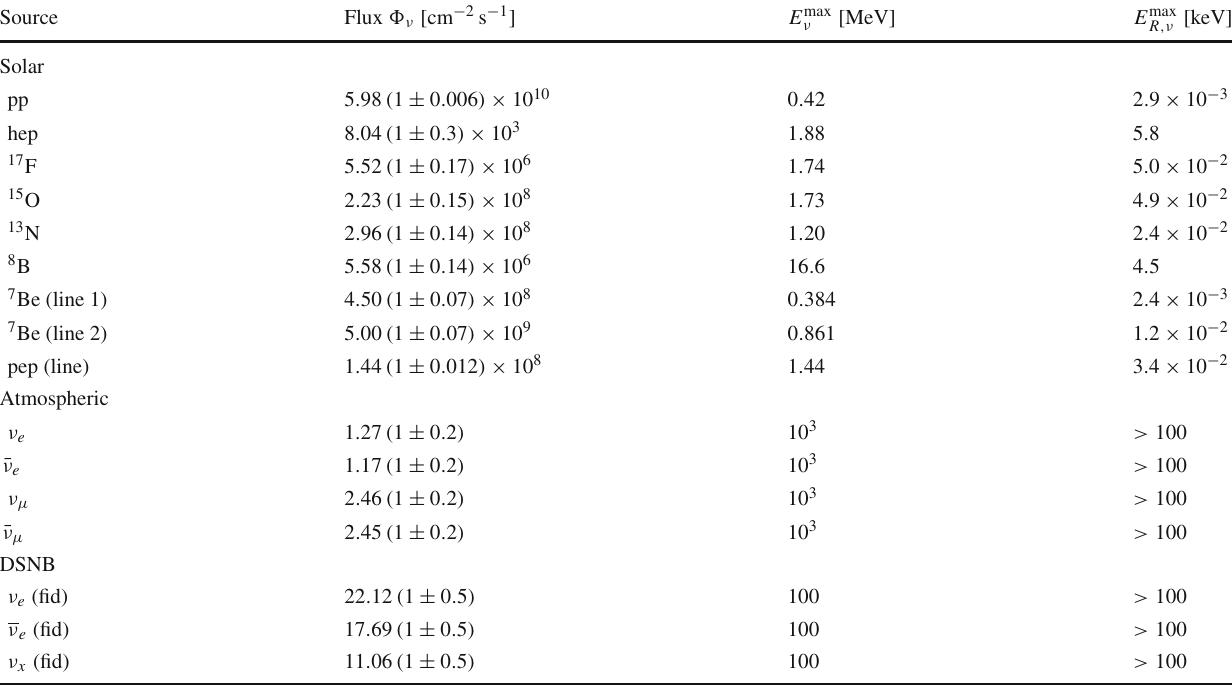
Table 1 Adopted neutrino fluxes in this work; we follow [61–63] in their compilation of the fluxes (original works are referenced in the